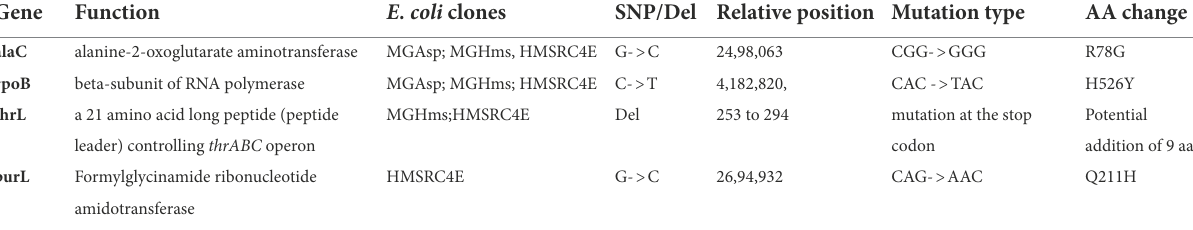
TABLE 2 Genomic modifications of E. coli clones adapted first on aspartate in a turbidostat mode (MG_Asp), then to L-homoserine by applying a medium swap (MG_Hms) and finally to L-homoserine in a turbidostat mode (HMSRC4E). Gene Function